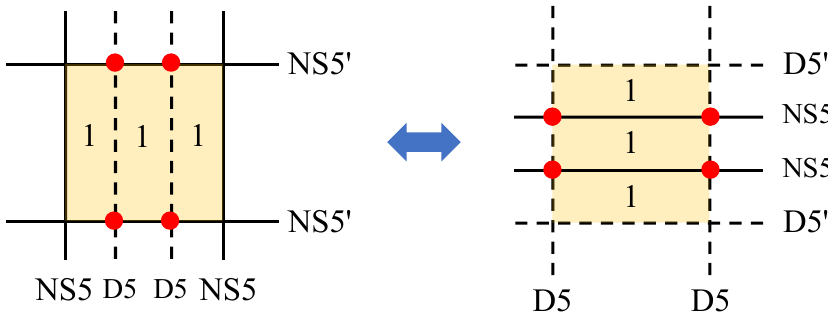
= (0 , 4) U(1) gauge theory with two charged N